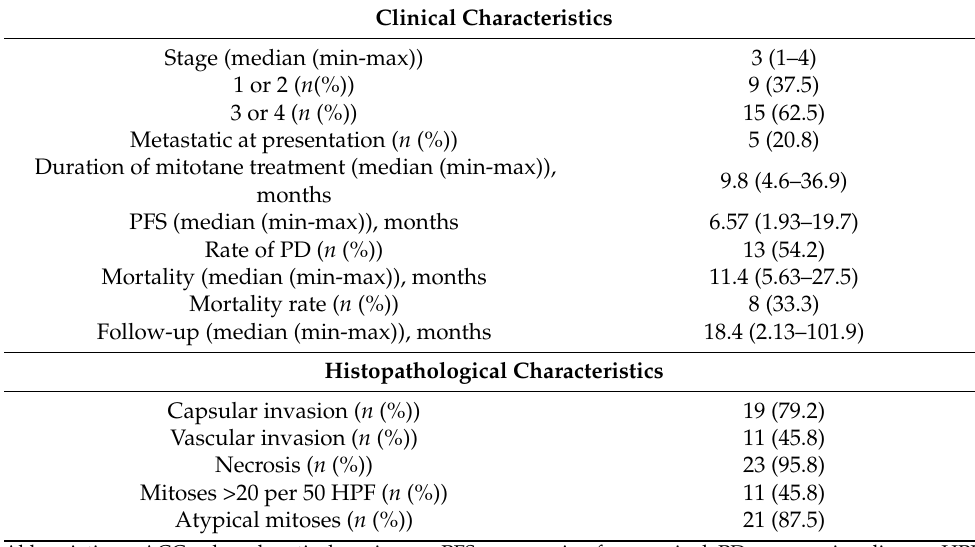
Table 2. Clinical and histopathological characteristics of ACC.